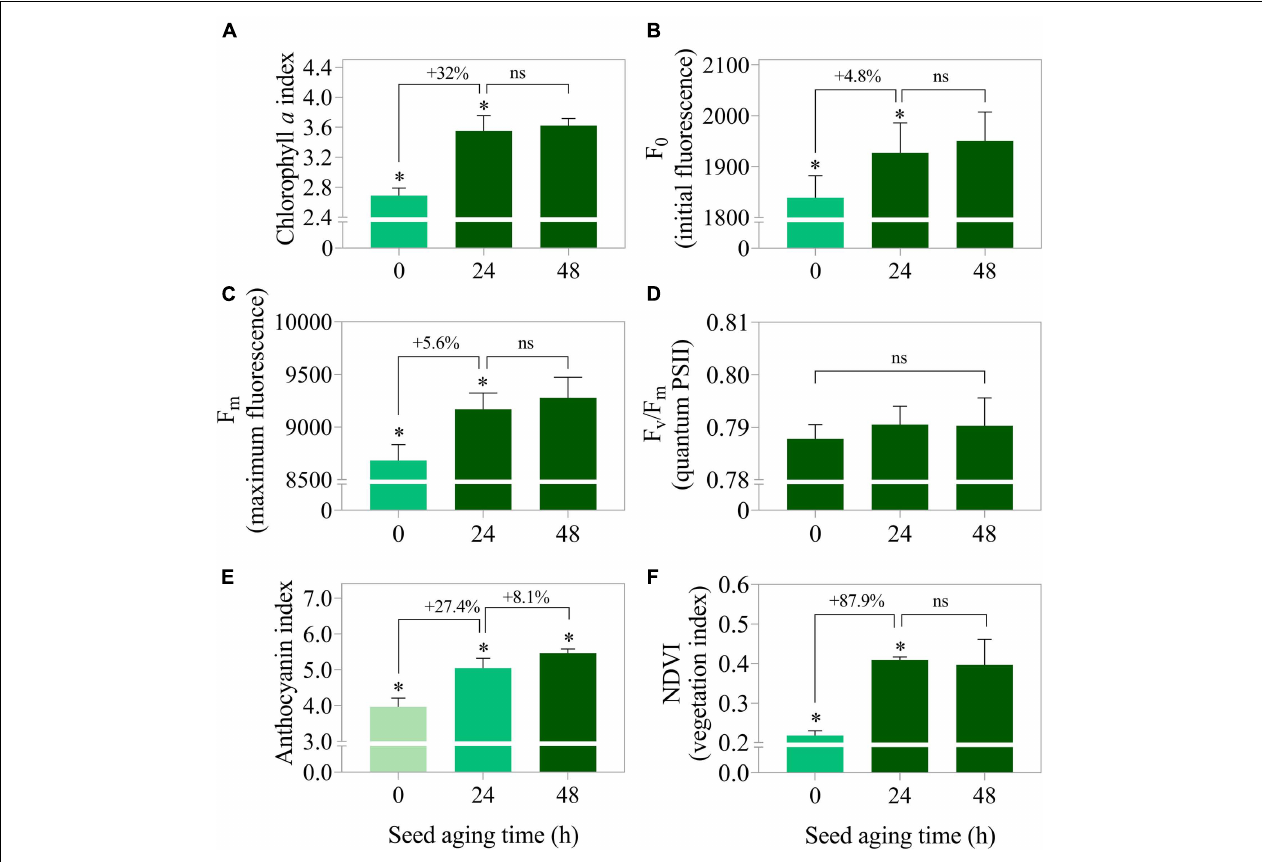
FIGURE 12 | Photosynthetic activity measured by chlorophyll a index (A) , initial fluorescence (F 0 ) (B) , maximum fluorescence (F m ) (C) , photosystem II quantum yield measured by F v /F m (D) as well as stress indicators such as anthocyanin index (E) , and normalized vegetation index (NDVI) (F) in peanut seedlings ( Arachis hypogaea L.; cv. IAC OL3) at 14 days after sowing: excitation of chlorophyll molecules were induced at 620 nm and emission at 700 nm. Means ( ± standard deviation). Asterisks ( ∗ ) indicate significant differences ( p ≤ 0.05). Peanut seedlings were obtained from lot 7 seeds after aging times (0 h, 24 h, and 48 h at 42 ◦